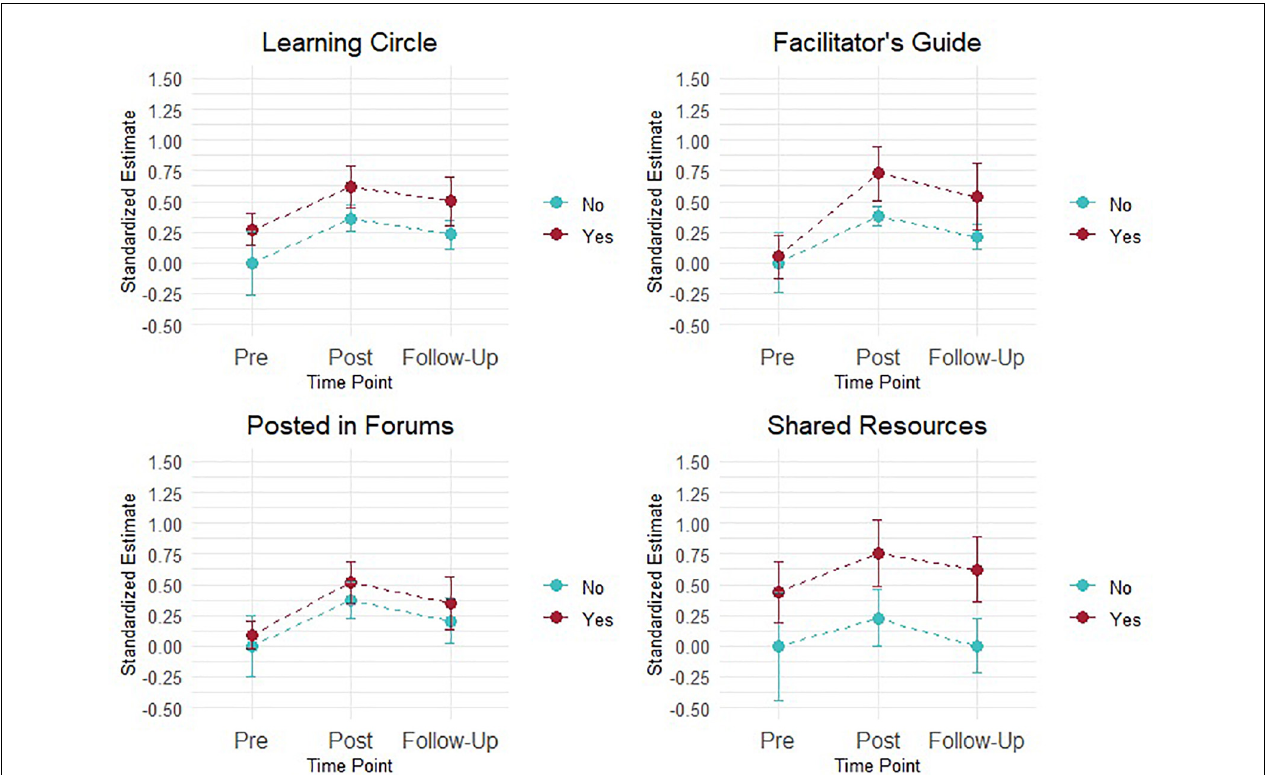
FIGURE 3 | Estimated changes in practices from pre-survey average by collaboration